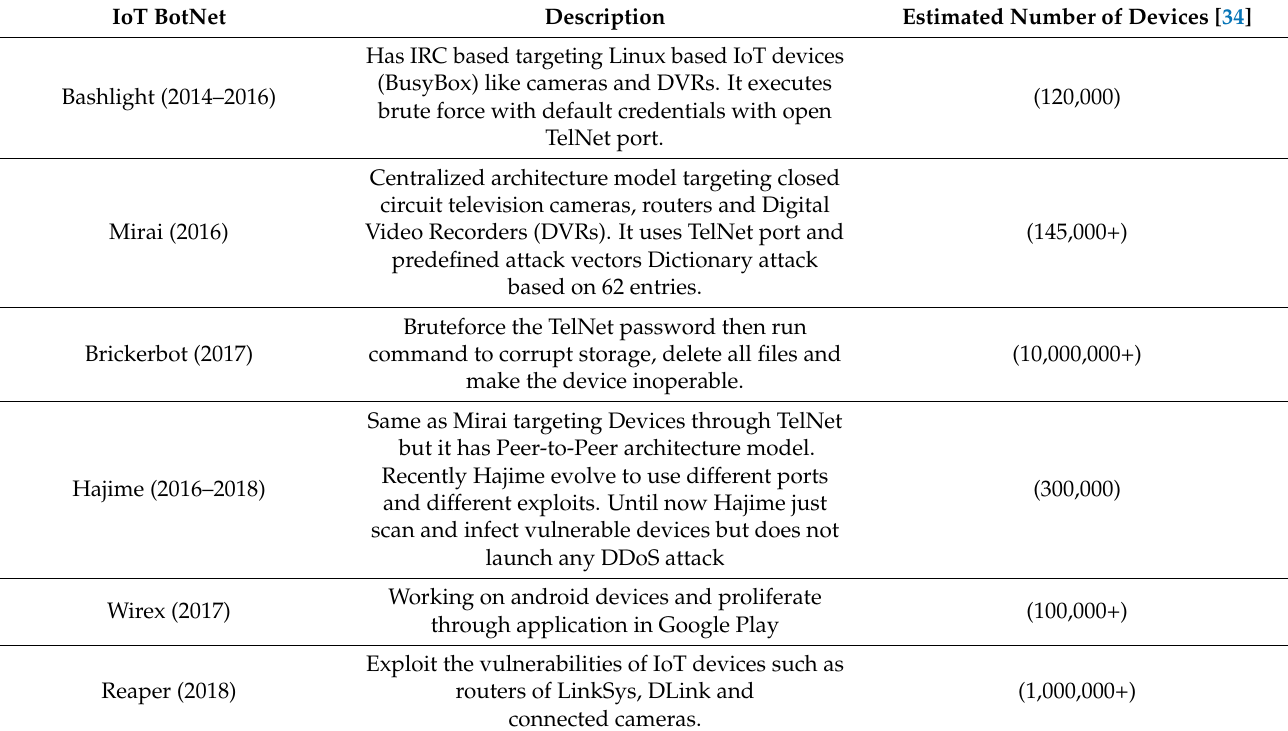
Table 2. IoT malware